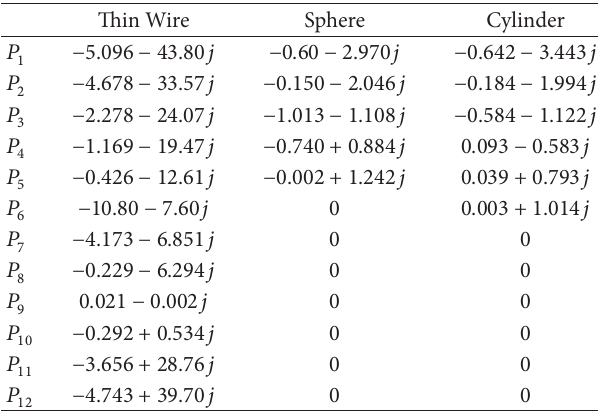
Table 2: Features extracted by MPMFD from a thin wire ( 𝑙 = 3 m), a sphere ( 𝑟 = 0.3 m), and a cylinder ( 𝑙 = 0.6 m, 𝑟 = 0.2 m) (poles × 10 8 ).